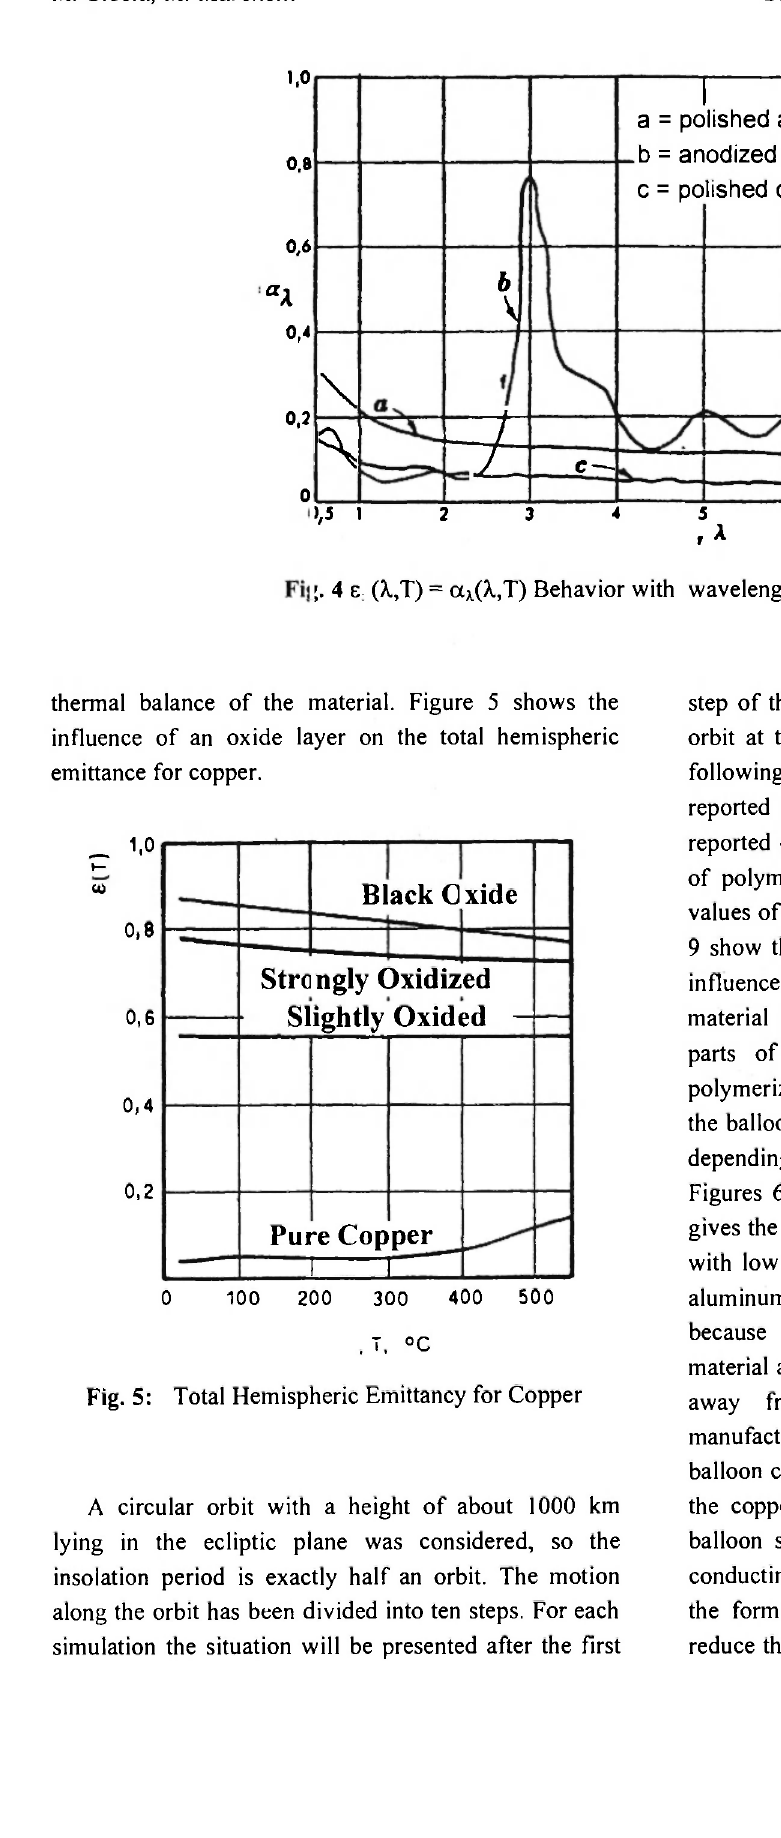
A circular orbit with a height of about 1000 km lying in the ecliptic plane was considered, so the insolation period is exactly half an orbit. The motion along the orbit has been divided into ten steps. For each simulation the situation will be presented after the